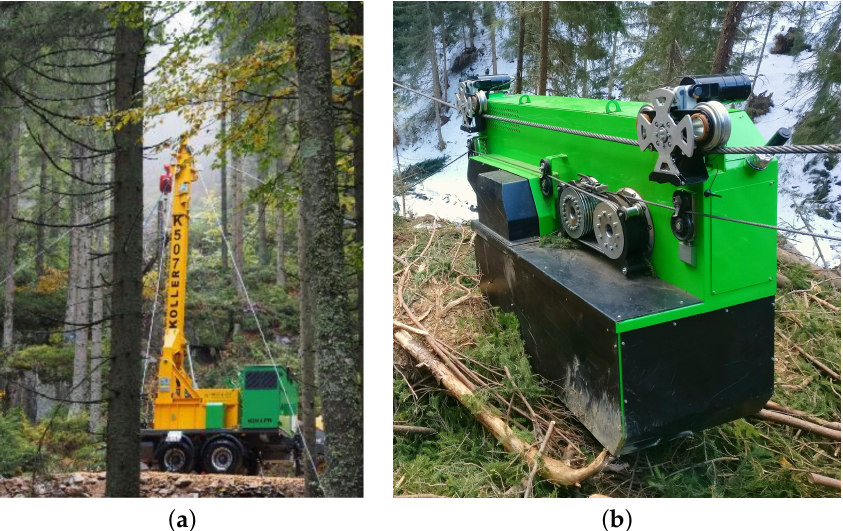
Figure 1. E-powered cable logging systems under development. ( a ) Hybrid tower yarder by Koller Forsttechnik. Image taken from [18]. ( b ) Hybrid self-propelled skyline crane by Leitalpin.